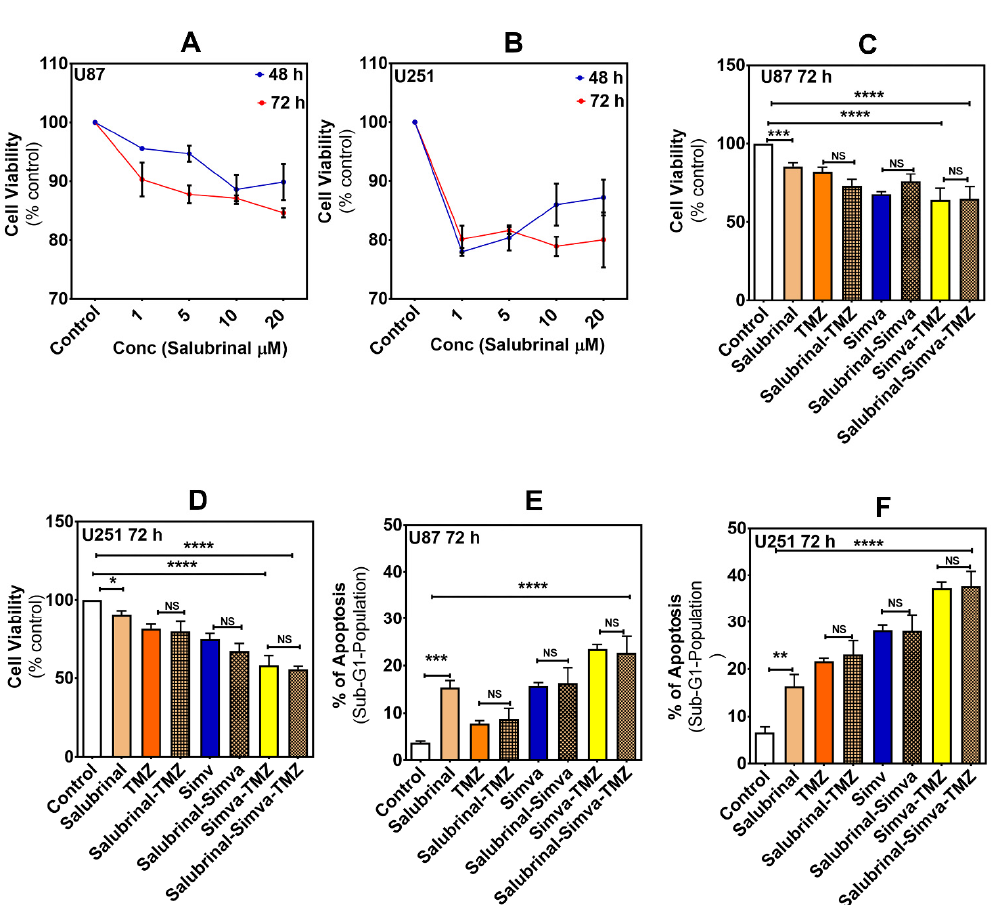
Figure 8. p-eIF2 α phosphatase inhibition does not a ff ect the cytotoxicity of Simva–TMZ in GBM cells. ( A , B ) U87 and U251 cells were treated with di ff erent concentrations of p-eIF2 α phosphatase inhibitor (salubrinal; 1, 5, 10, and 20 µ M) for 48 and 72 h. Controls were treated with the solvent (DMSO). Salubrinal induced significant cell death in both cell lines, except for 1 µ M in U87 cells in 48 h. ( C , D ) U87 and U251 cells were pretreated with salubrinal (15 µ M, 30 min) and then co-treated with Simva, TMZ, or Simva–TMZ for 72 h; cell viability was measured by MTT assay. Salubrinal had no significant e ff ects on Simva-, TMZ-, or Simva–TMZ-induced cell death in either cell line. ( E , F ) U87 and U251 cells were pretreated with salubrinal (15 µ M, 30 min) and then co-treated with Simva, TMZ, or Simva–TMZ for 72 h; apoptosis was measured by Nicoletti assay. Salubrinal had no significant e ff ects on Simva-, TMZ-, or Simva–TMZ-induced apoptosis in either cell line. Data are expressed as the means ± SD of 15 replicates from three independent experiments for MTT assay and three independent replicates for Nicoletti assay (* p < 0.05; ** p < 0.01, *** p < 0.001, **** p <